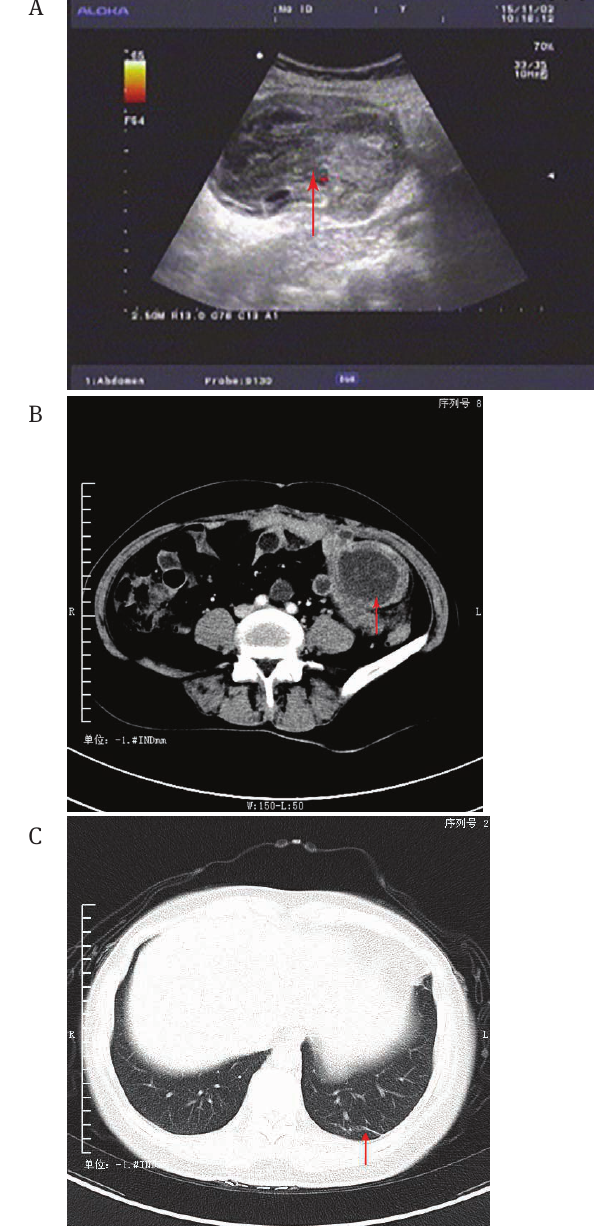
Figure 2: Auxiliary examinations of the patient, the abnormal sites have been labeled by red arrows. There was a mixed echogenic mass in her left lower quadrant of the abdomen on sonography (2A, on the left). There was a large lesion in the left lower abdominal mesenteric area as observed on abdominal CT images (2B, middle). Her thorax CT scans showed a funicular image in the inferior lobe of the left lung (2C, right).